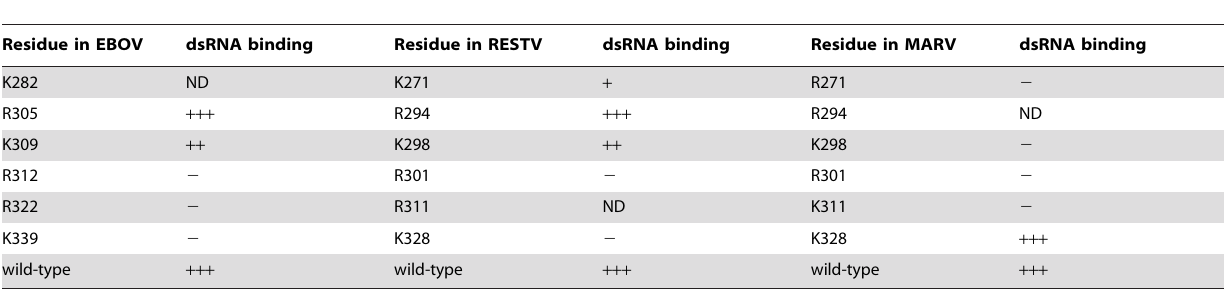
Table 5. Importance of individual residues in the central basic patch of filovirus VP35 RBDs for binding dsRNA [10,22].